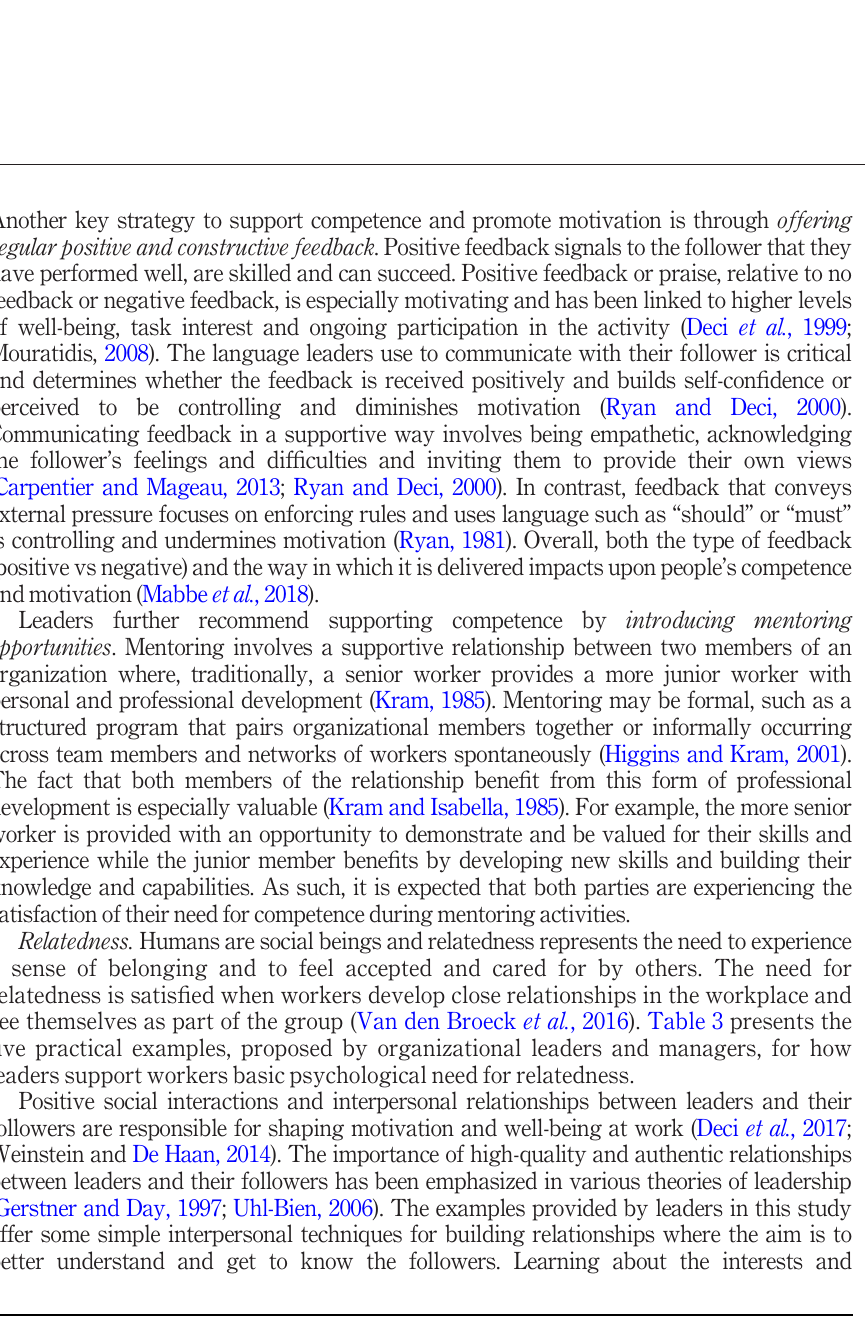
Table 3. How leaders